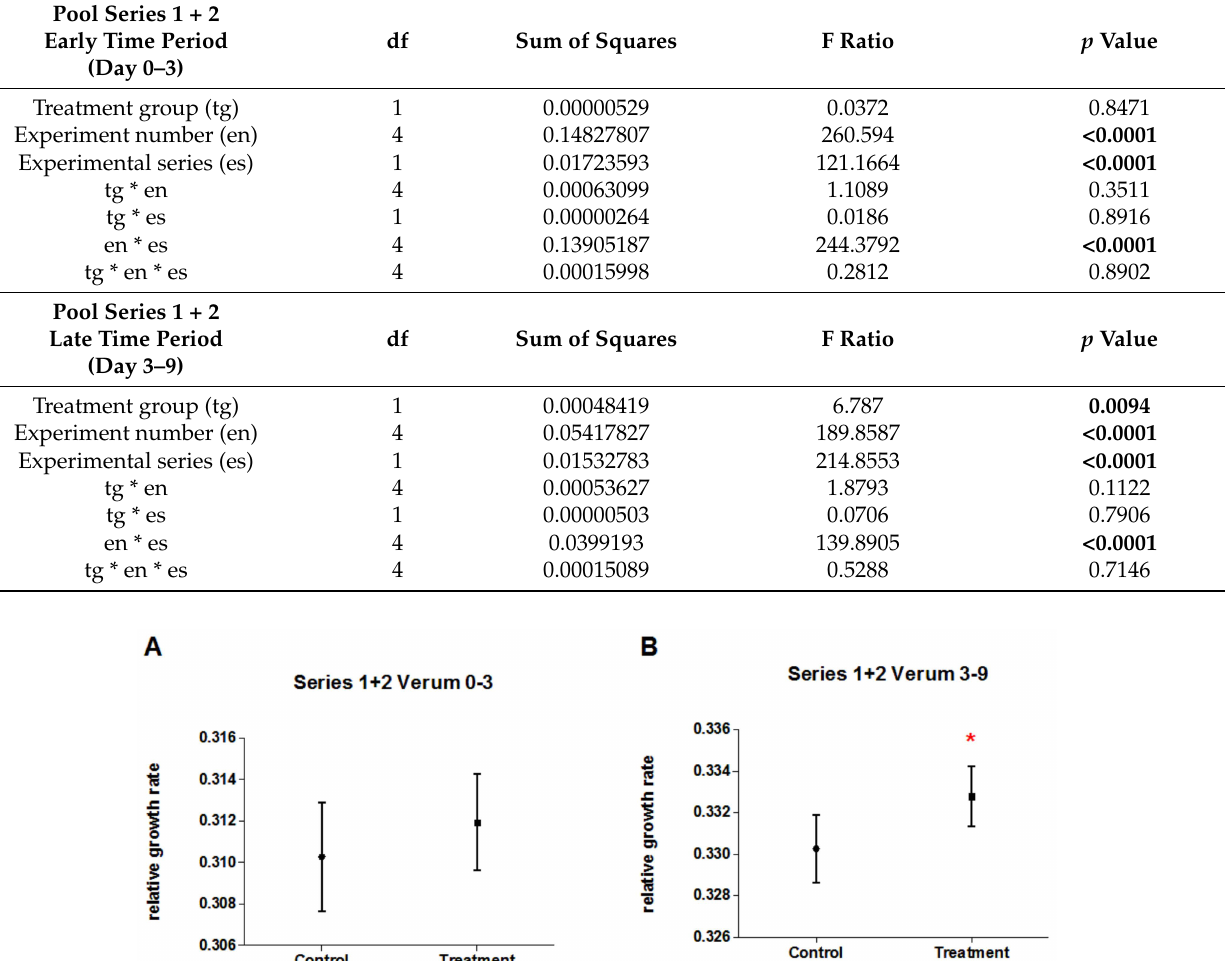
Figure 9. Mean relative growth rate ( ± 95% CI) of duckweed treated with either potentised As 2 O 3 (potency levels 17x–18x, 21x–23x, 28x, 30x, 33x, numerically pooled, n = 400) or water as control (unsuccussed and succussed water samples, numerically pooled, n = 340) in the 10 independent experiments of series 1 and series 2. ( A ) Early time period (day 0–3), ( B ) Late time period (day 3–9), * p <